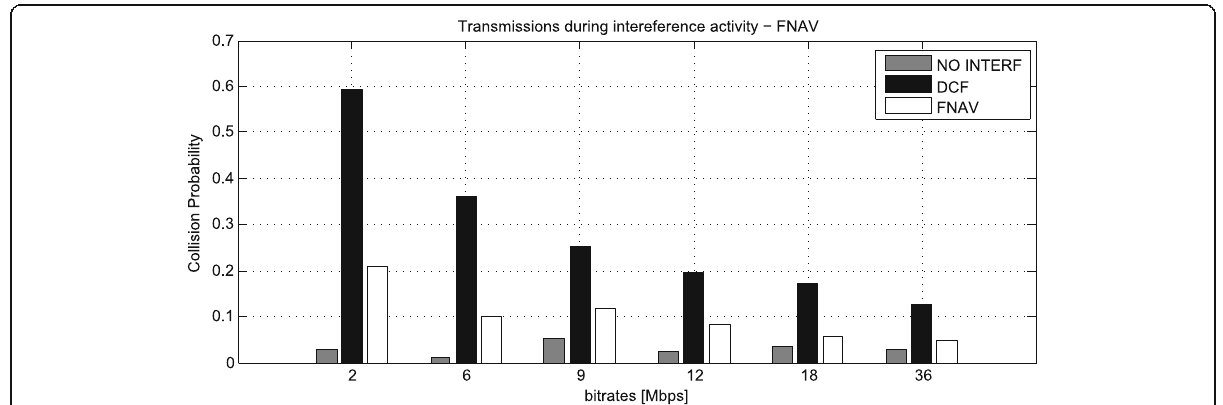
Fig. 8 Collision probability for different values of the bit rate